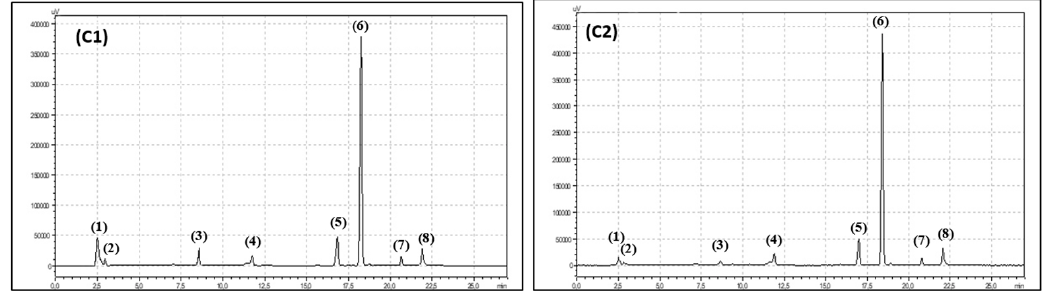
Figure 4. Chromatogram showing retention times for organic raspberry ( C1 ) and conventional raspberry leaves ( C2 ) carotenoids and chllorophylls: (1) lutein, (2) zeaxanthin, (3) neoxanthin, (4) violaxanthin, (5) chlorophyll b, (6) chlorophyll a, (7) alpha-carotene, (8) beta-carotene.